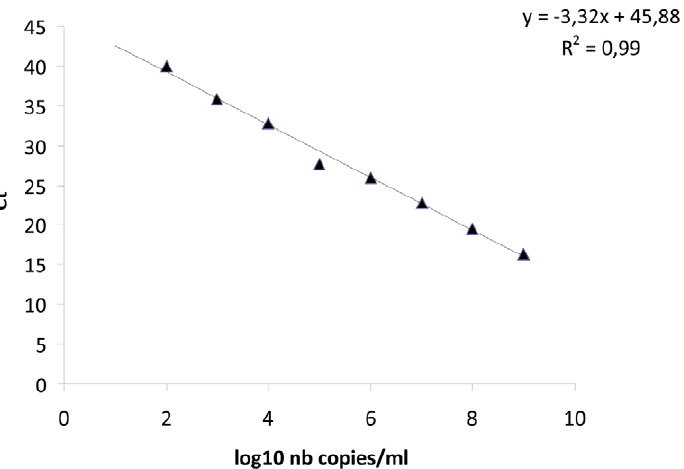
Figure 2. The mean ± standard error of the mean (SEM) of log10 copies obtained using qPCR. Culture pos: culture positive skin biopsies, Culture neg: culture negative skin biopsies; No treatment: skin biopsies obtained from patients without treatment, Treatment: skin biopsies obtained from patients receiving a treatment; Marseille: skin biopsies obtained from patients from Marseille, No: skin biopsies obtained from patients from elsewhere; D. marginatus-R. slovaca : D. marginatus ticks infected by R. slovaca , D. marginatus-R. raoultii : D. marginatus ticks infected by R. slovaca .